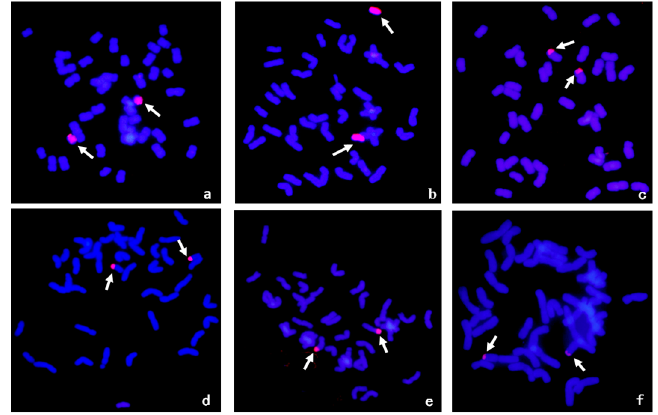
Figure 2. GISH patterns of wheat- A . cristatum 6P homozygous strains. A . cristatum chromosomes were in red, while wheat chromosomes were in blue strained by DAPI. ( a ) del21; ( b ) del19a; ( c ) WAT641a; ( d ) WAT657; ( e ) WAT648; and ( f ) WAT646. The homozygous materials carried a pair of chromosomal segments.